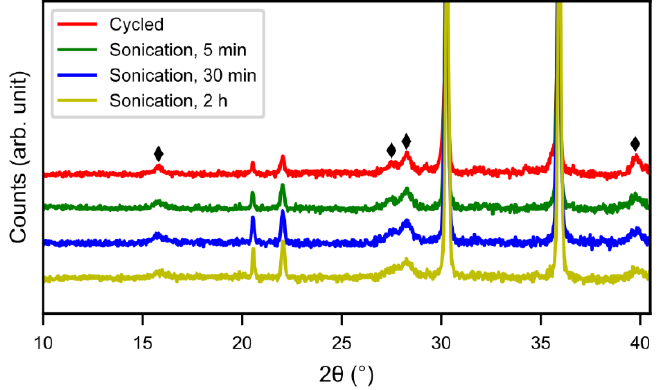
Figure 2. XRD patterns of the sonotrode-sonicated cycled alloy at 5 min, 30 min, and 2 h, respectively. ( (cid:7) ) RE(OH) 3 .